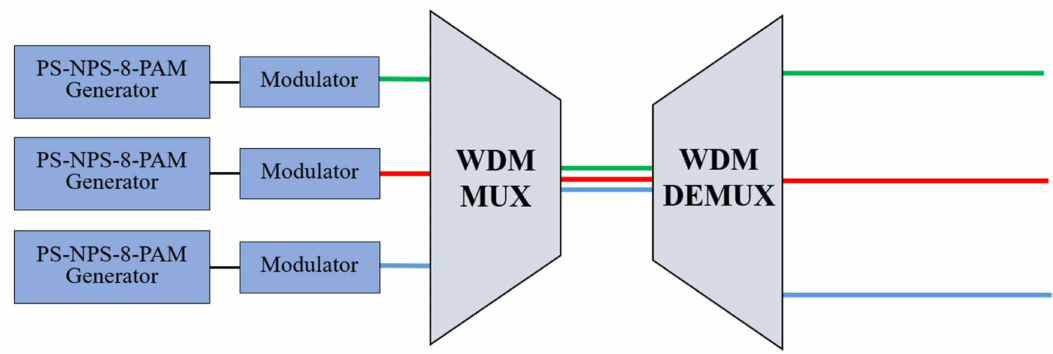
Figure 3. Structure of the PS-NPS-8-PAM-based DWDM system. DEMUX: demultiplexer.